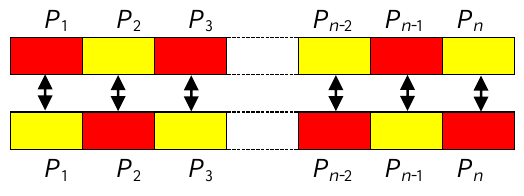
Figure 2. A schematic representation of uniform